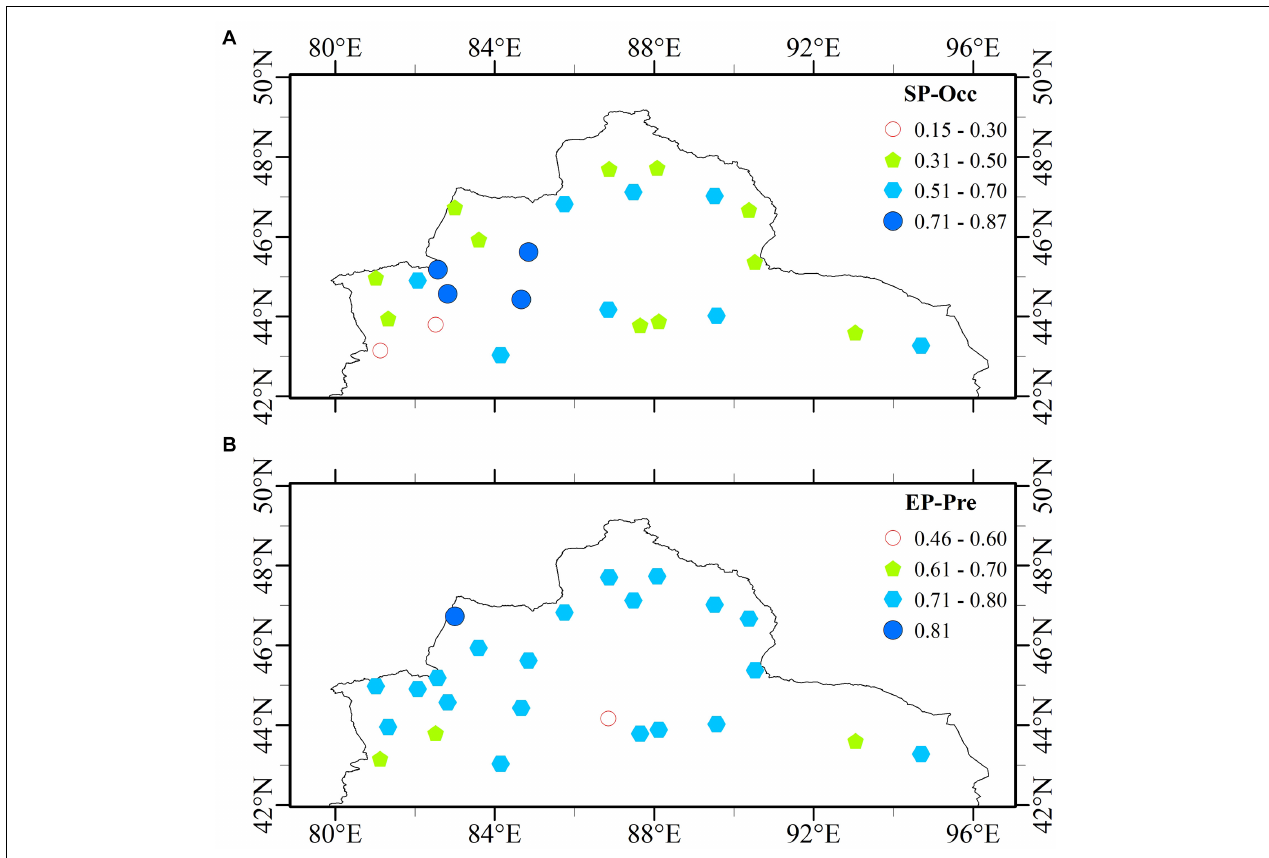
FIGURE 5 | The coefficient of determination at each station in Northern Xinjiang for: (A) the annual occurrence of SP events and the annual number of wet days, and (B) the annual precipitation amount attributable to EP events and the total annual precipitation amount.